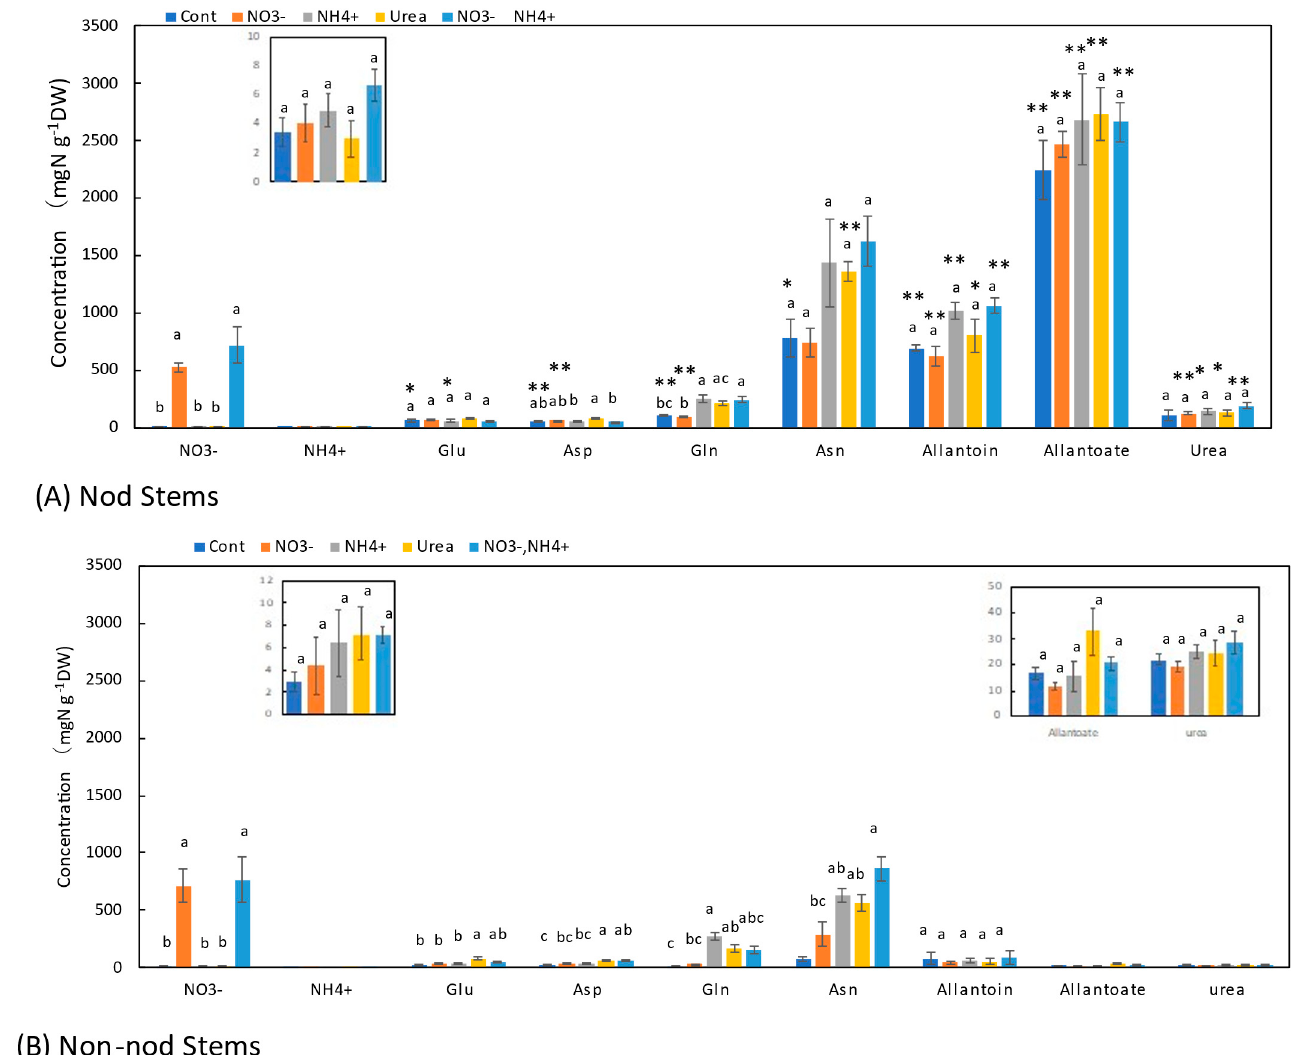
Figure 6. Comparison of the concentrations of the principal N metabolites in the stems of the Nod and Non-nod soybean plants treated with the various N compounds. The symbols, abbreviations and the explanations of the statistics are the same as in Figure 2.